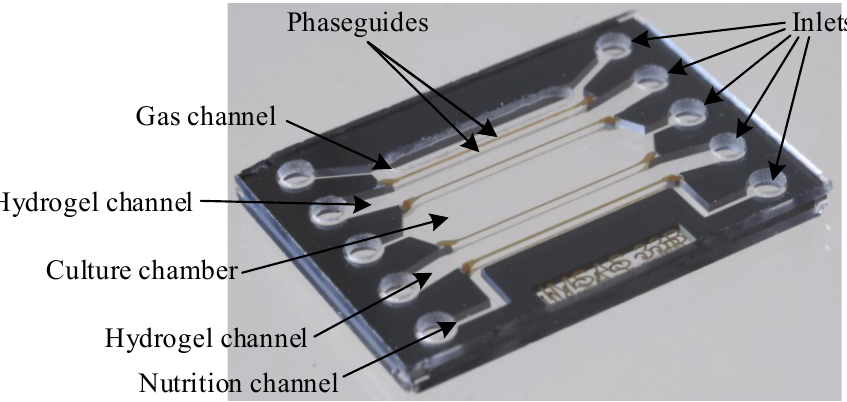
Figure 5. Image of the fabricated chip. The size of the chip is 13 × 17 × 1.4mm 3